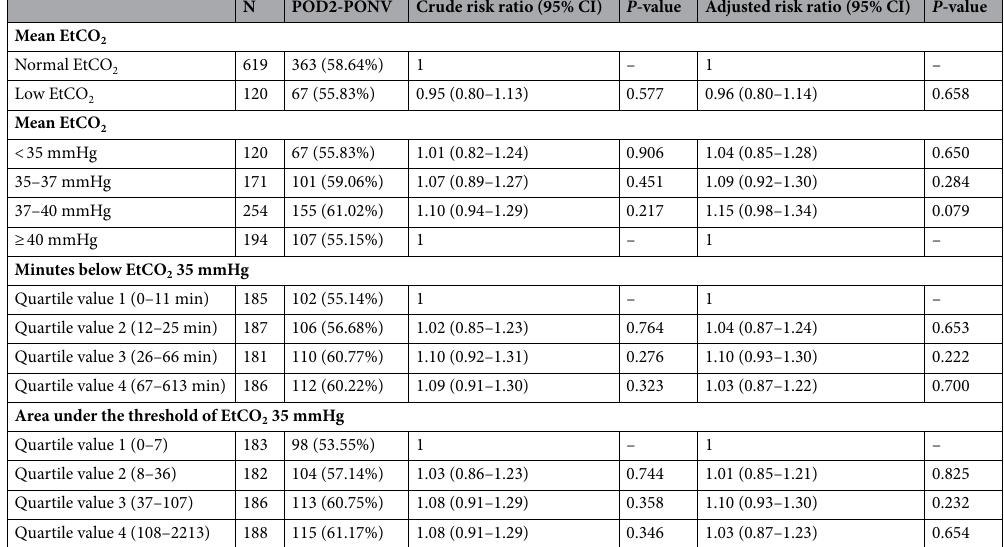
Table 2. Multivariable analysis of the relationship between EtCO 2 and POD2-PONV. EtCO 2 end-tidal carbon dioxide, POD 2 postoperative day 2, PONV postoperative nausea and vomiting, CI confidence interval.